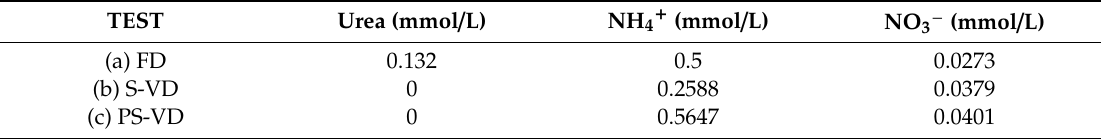
Table2. Urea(mmol / L),NH 4 + (mmol / L),andNO 3 − (mmol / L)concentrationsafter240minofirradiation, using light modulations on urea in distilled water with (a) FD LED dimming, (b) S-VD, and (c) PS-VD LEDs dimming modulations; initial urea concentration: 250 mg / L.